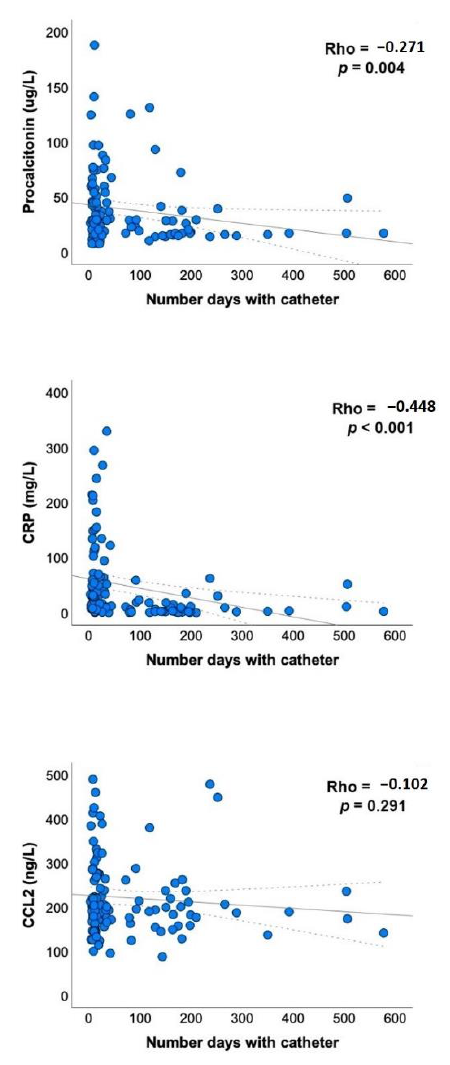
Figure 3. Relationships between the number of days the catheter was indwelling and the circulating levels of procalcitonin, C-reactive protein (CRP)m and the chemokine (C-C) motif ligand 2 (CCL2) in patients with a central venous catheter. Statistical analyses used Spearman’s Rho test. Among the 23 patients with a CVC and CRI, 11 (47.8%) had catheter-only colonization, 9 (39.1%) had infection at the insertion site, and 3 (13.0%) had catheter-related bacteremia. Among UC patients, the urine culture was negative in 135 patients (82%), positive for gram-negative bacteria in 13 patients (7.8%), positive for gram-positive bacteria in 8 patients (4.8%), and positive for assorted fungi in 9 patients (5.4%). The infection rate in our patients was relatively low because we had a high number of patients in the postoperative period of prostate resection and thus had the catheter for a few days, meaning the risk of infection was low. The identified strains and colony forming units (CFU)/L are shown in Table 3. We did not observe any significant difference in the circulating levels of galectin-3 depending on the identified